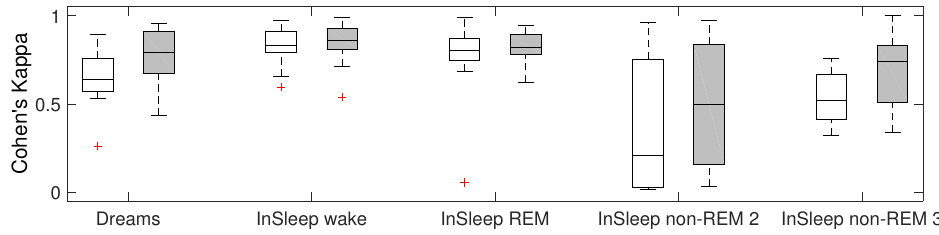
Figure 7. Distribution of Cohen’s kappa for the Dreams and InSleep datasets. White boxes represent the benchmark; grey boxes represent the proposed